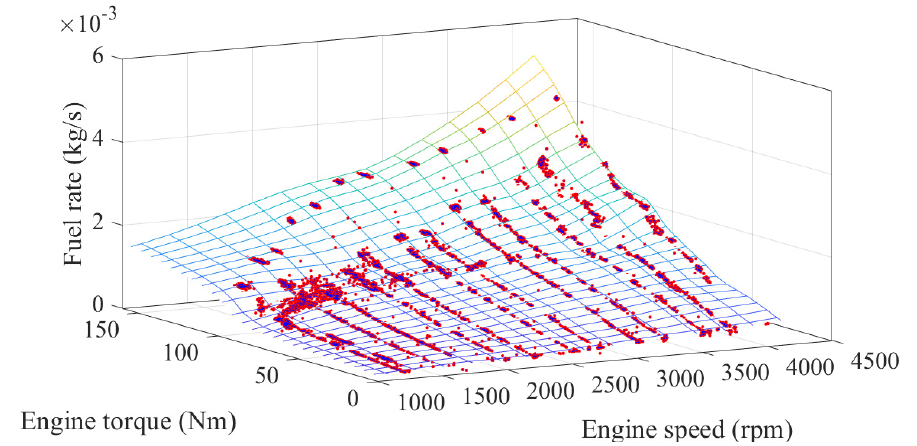
Figure 15. Engine Fuel Map Based on Load Tests.